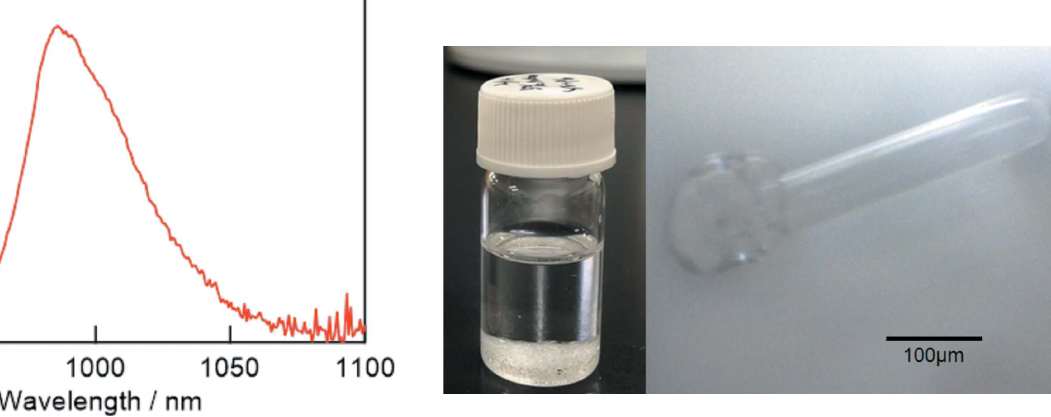
Figure 5 Photographs of crystals in solution and of the single crystal used for the